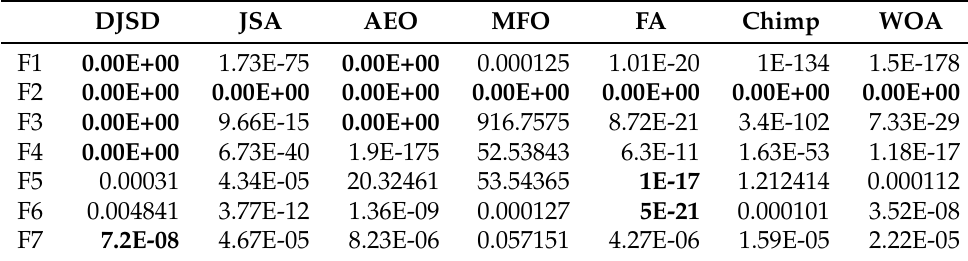
Table 5. Best fitness values obtained by each